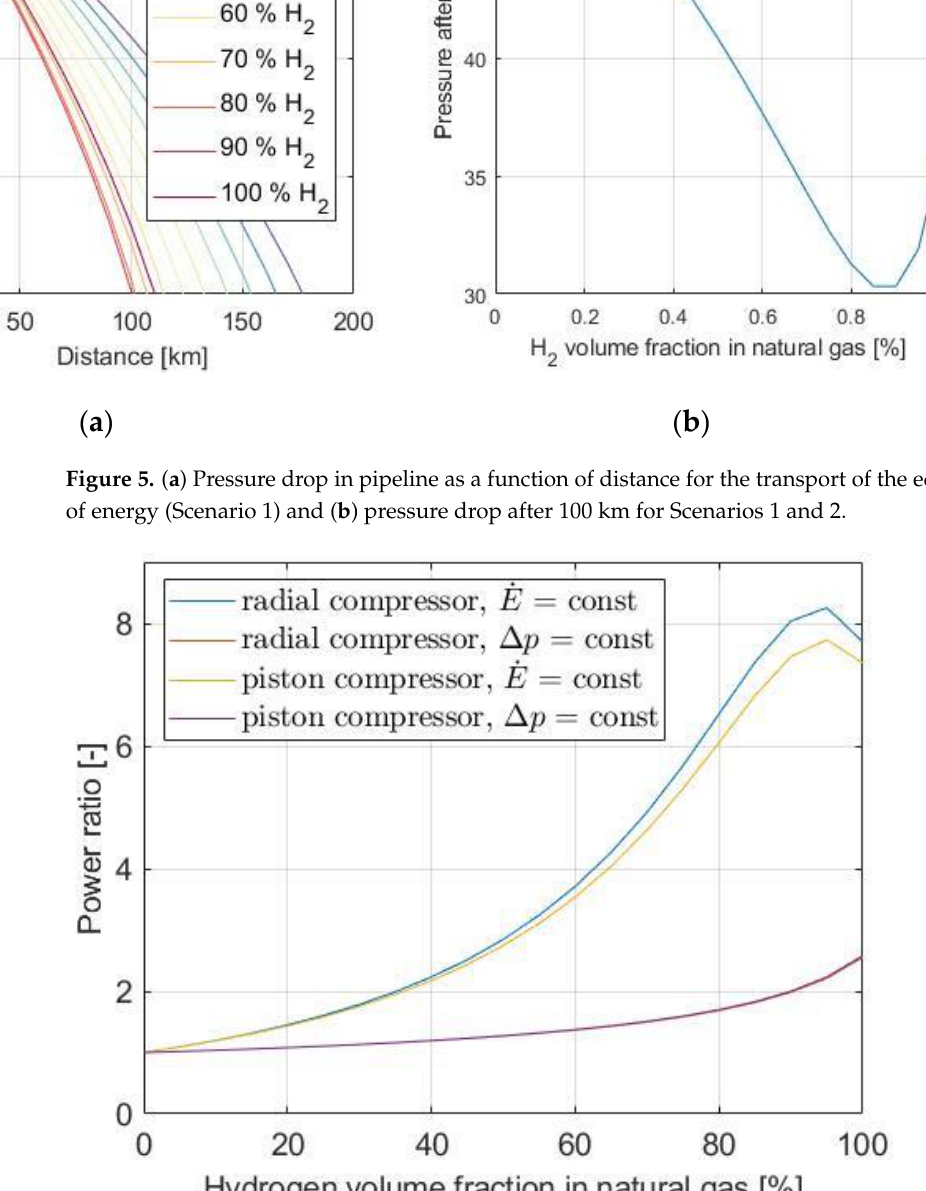
Figure 6. Compressor power of the thermodynamic equivalent processes of piston and radial com- pressor.